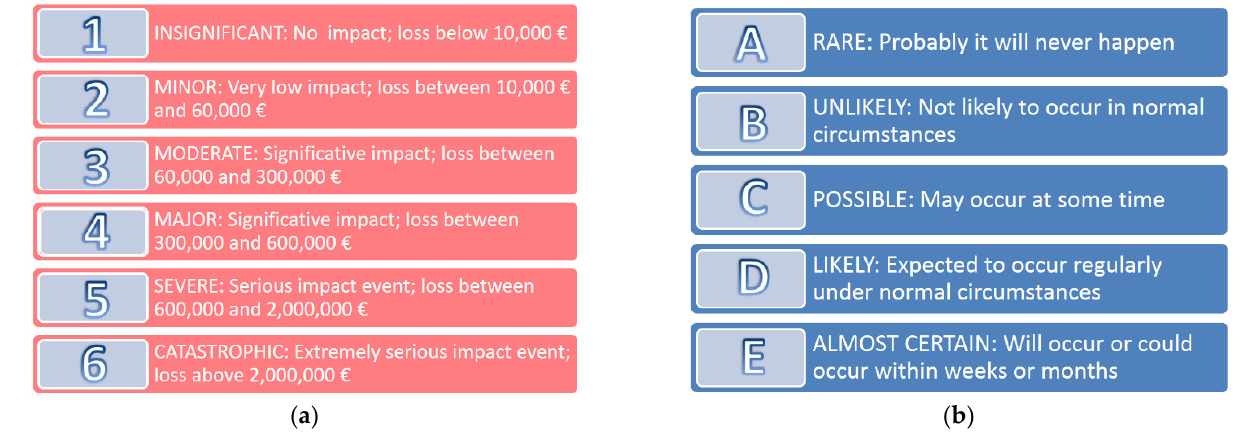
Figure 3. ( a ) Scale of consequences according to the economic impact of losses defined by mining insurance companies; ( b ) Likelihood rating.